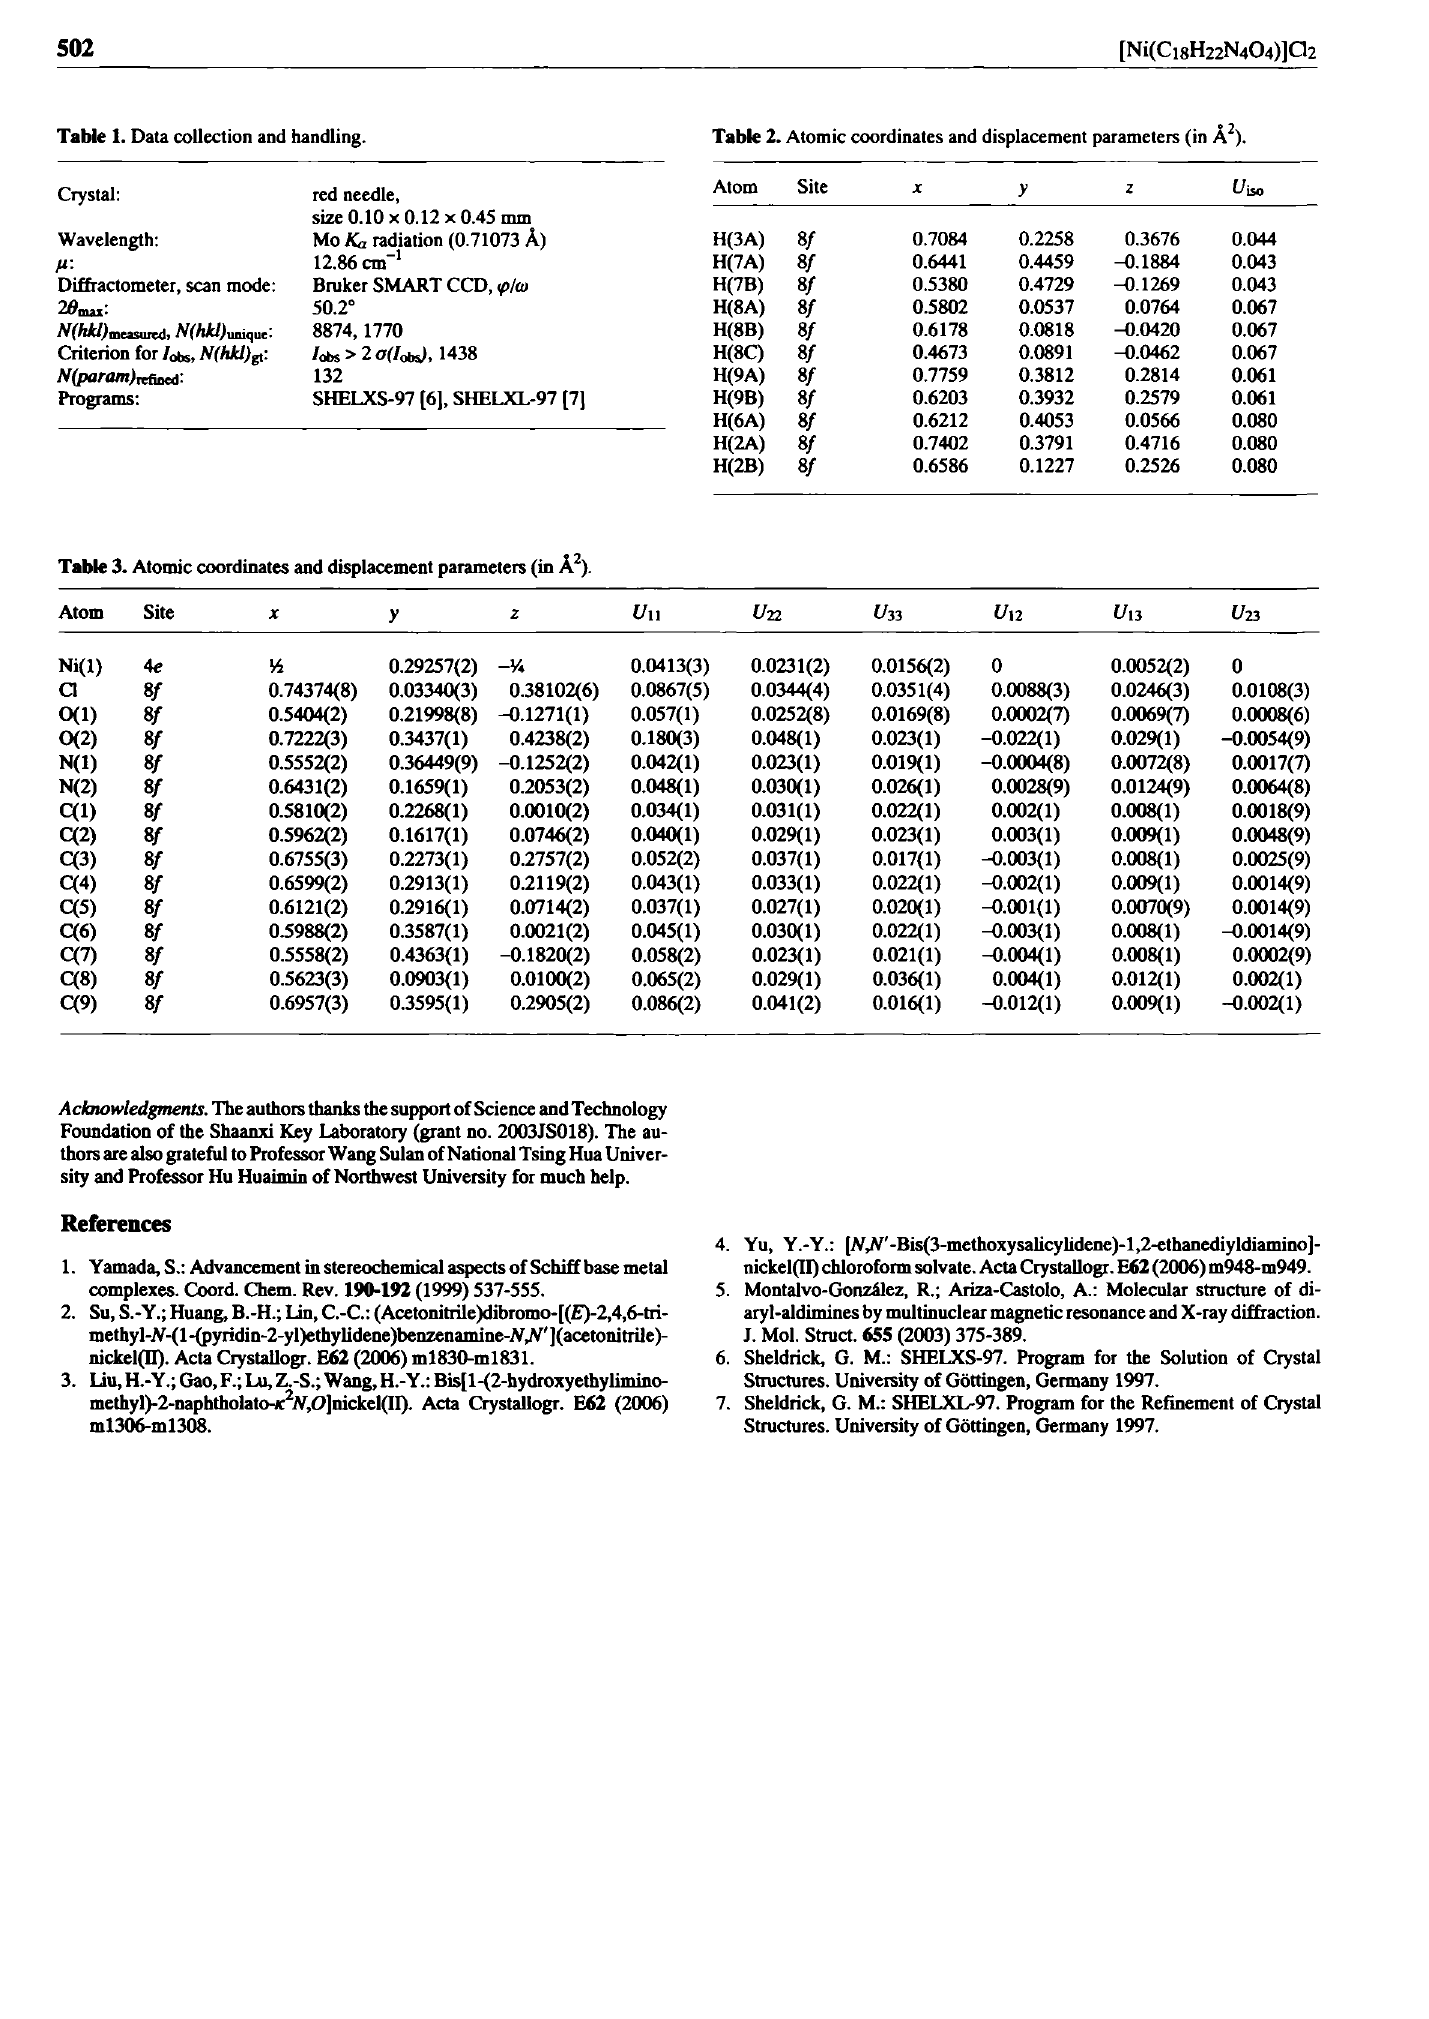
Table 1. Data collection and handling. Table 2. Atomic coordinates and displacement parameters (in A 2 ).